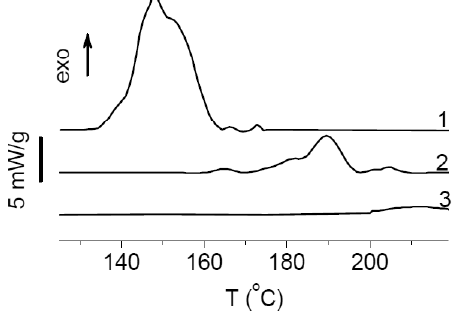
Fig. 3. Differential scanning calorimetric curves ob- tained during the first heating of Al samples sub- jected to HPT processing (1) and subsequent an- nealing for 1 h at 90 ° C (2) and 200 ° C (3).